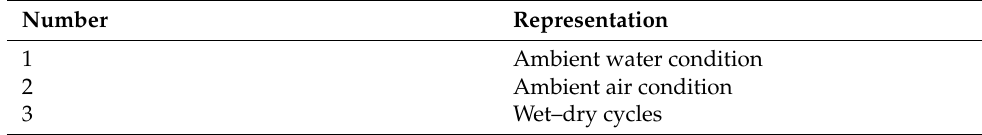
Table A3. Types of healing